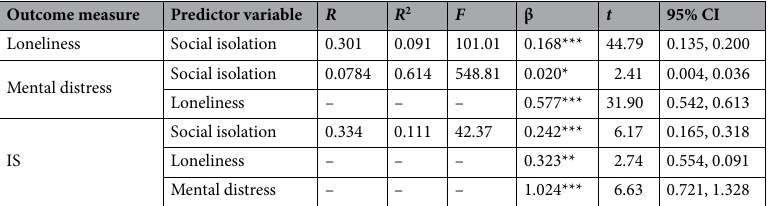
Table 3. Regression coefficients in the serial multiple mediation analysis ( N = 1201). Each model was adjusted for age, sex, residential status, education level, income level, marital status, physical activity, self-rated health, multimorbidity, and functional limitations. IS impaired sleep. *** p ˂ 0.001; ** p ˂ 0.005; * p ˂ 0.05.